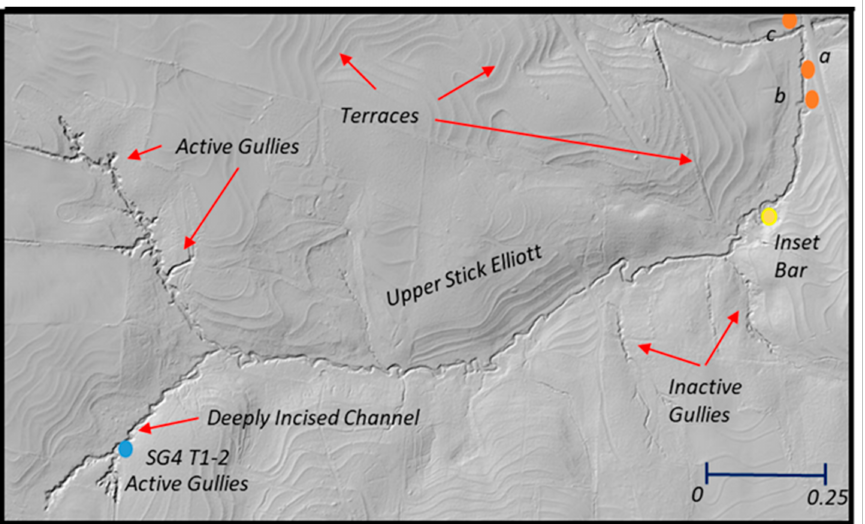
Figure 5. LiDAR DEM showing detailed view of geomorphic features along Stick Elliott Creek. Lettered orange circles represent the locations of photographs shown in Figure 2; blue circle represents inset terrace with dated trees. LiDAR DEM from the North Carolina Spatial Data Download Center (https://sdd.nc.gov/, accessed on 10 October